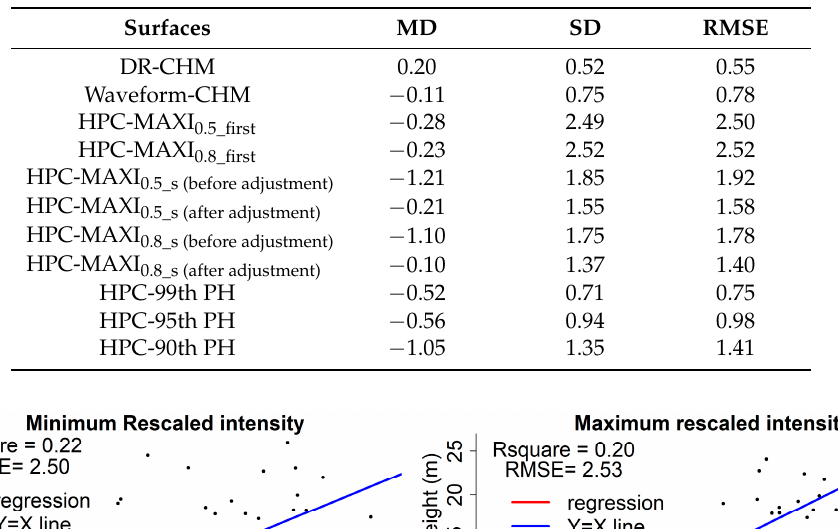
Table 3. Tree height estimation using DR-based CHM, waveform-based CHM, the HPC-based MAXI surfaces with the first method (HPC-MAXI 0.5_first & HPC-MAXI 0.8_first ) and the second method (HPC-MAXI 0.5_s (before adjustment) , HPC-MAXI 0.5_s (after adjustment) , HPC-MAXI 0.8_s (before adjustment) & HPC-MAXI 0.8_s (after adjustment) ) and HPC-based PH (99th, 95th, 90th) CHMs.